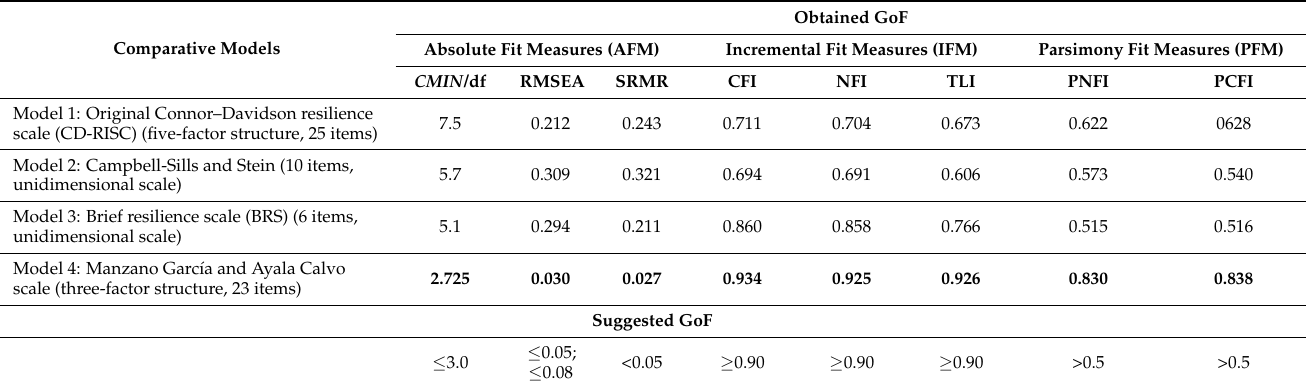
Table 5. Results of the comparative models